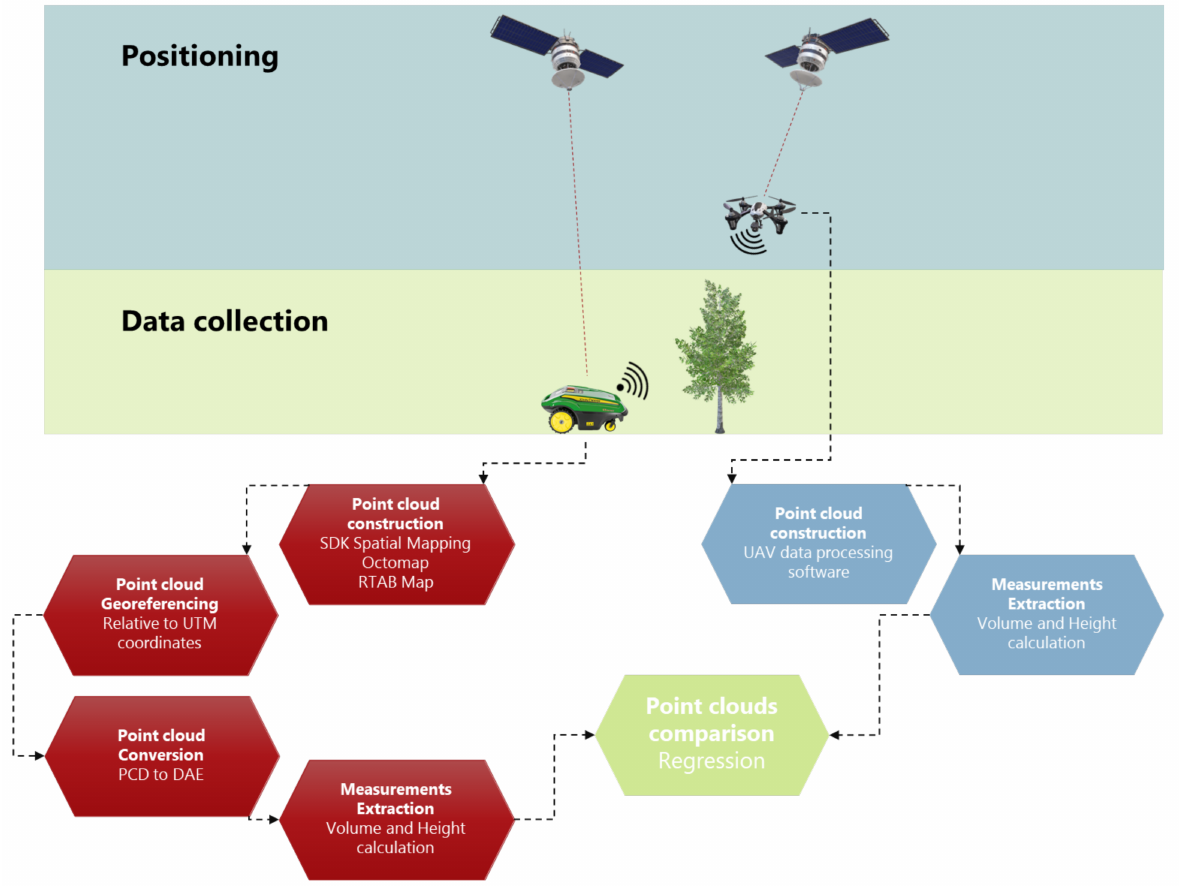
Figure 3. Flow chart of the procedure for the 3D point cloud construction using data from ZED 2 camera and its comparison with the UAV derived point